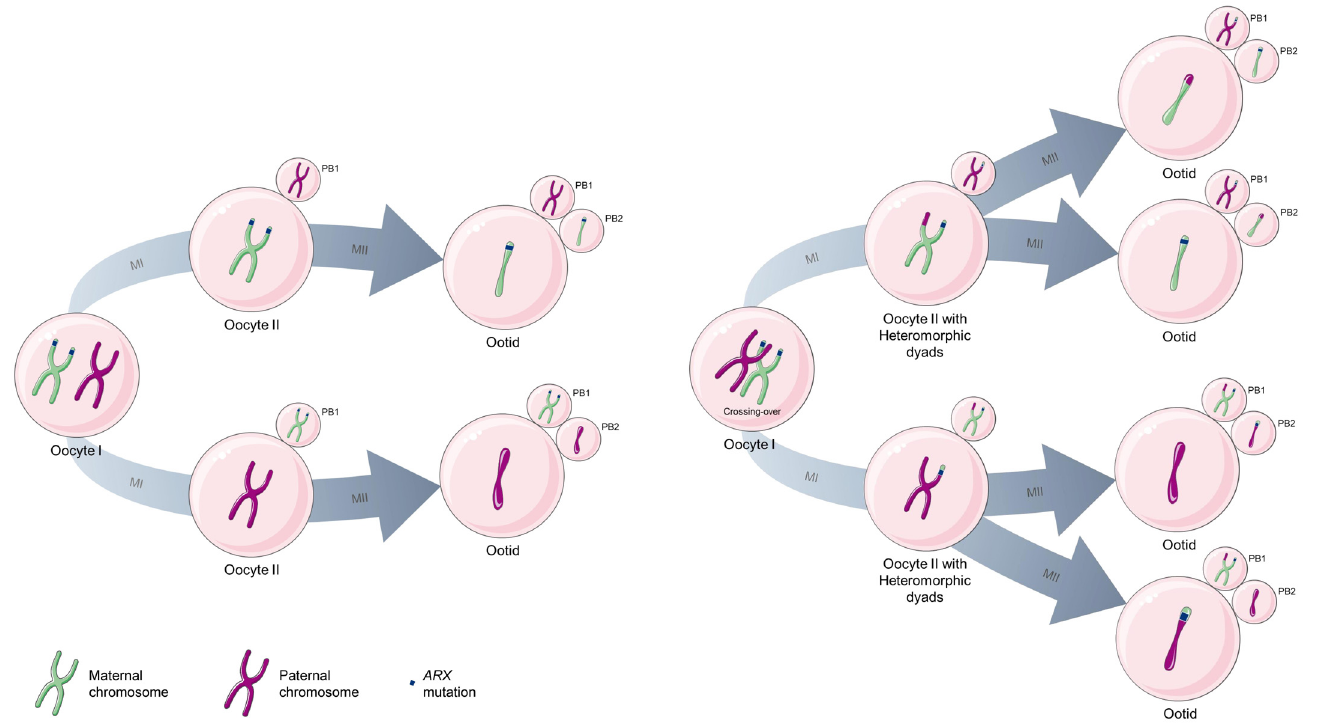
Figure 4. Oogenesis in heterozygous females for the ARX dup24 mutation. Without crossing-over between the centromere and the ARX locus ( left ) and with a crossing-over between the centromere and the ARX locus ( right ). During the first meiotic division (M1), there is a reductional division leading to the separation of homologous chromosomes. There are two possibilities: the maternal chromosome segregates in oocyte II while the paternal one segregates to the first polar body (PB1), or vice versa. During the second meiotic division (M2), there is an equational division, with separation of sister chromatids. One of the chromatids segregates in the ootid while the other one segregates to the second polar body (PB2).